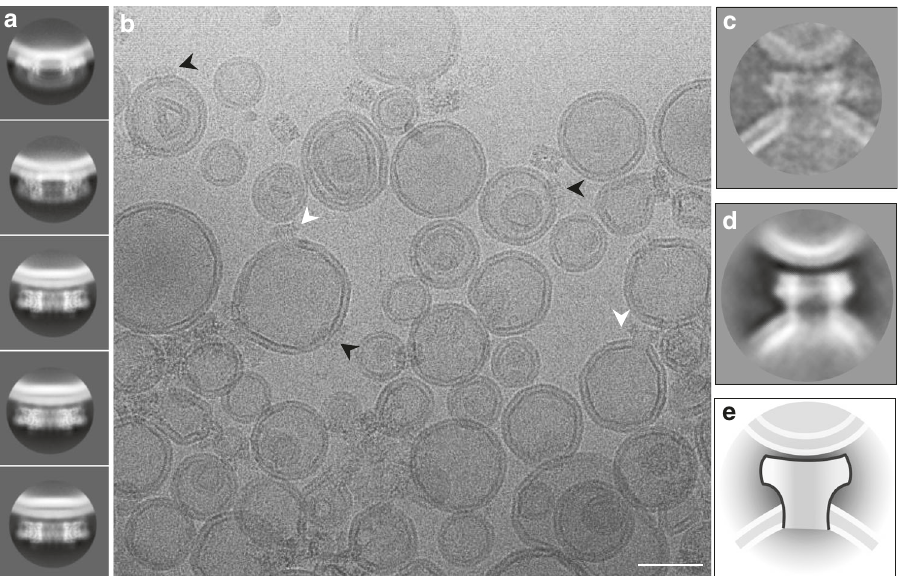
Fig. 4 The MACPF domain of MPEG1 is oriented away from the MABP-bound membrane. a Examples of MPEG1 bound to liposomes reveal b single rings bound in the prepore state (black arrows) and the occasional example of pores (i.e., the membrane is absent in the pore lumen), that coordinate a second liposome through the top portion of the ring (white arrow). We were not able to identify examples of pores bound to a single liposome, i.e. all pore structures we observed bridged between two liposomes. Class averages for prepores ( a ) and pores ( d ) are shown. For comparison, c a single pore, d a 2D class average and e illustration are